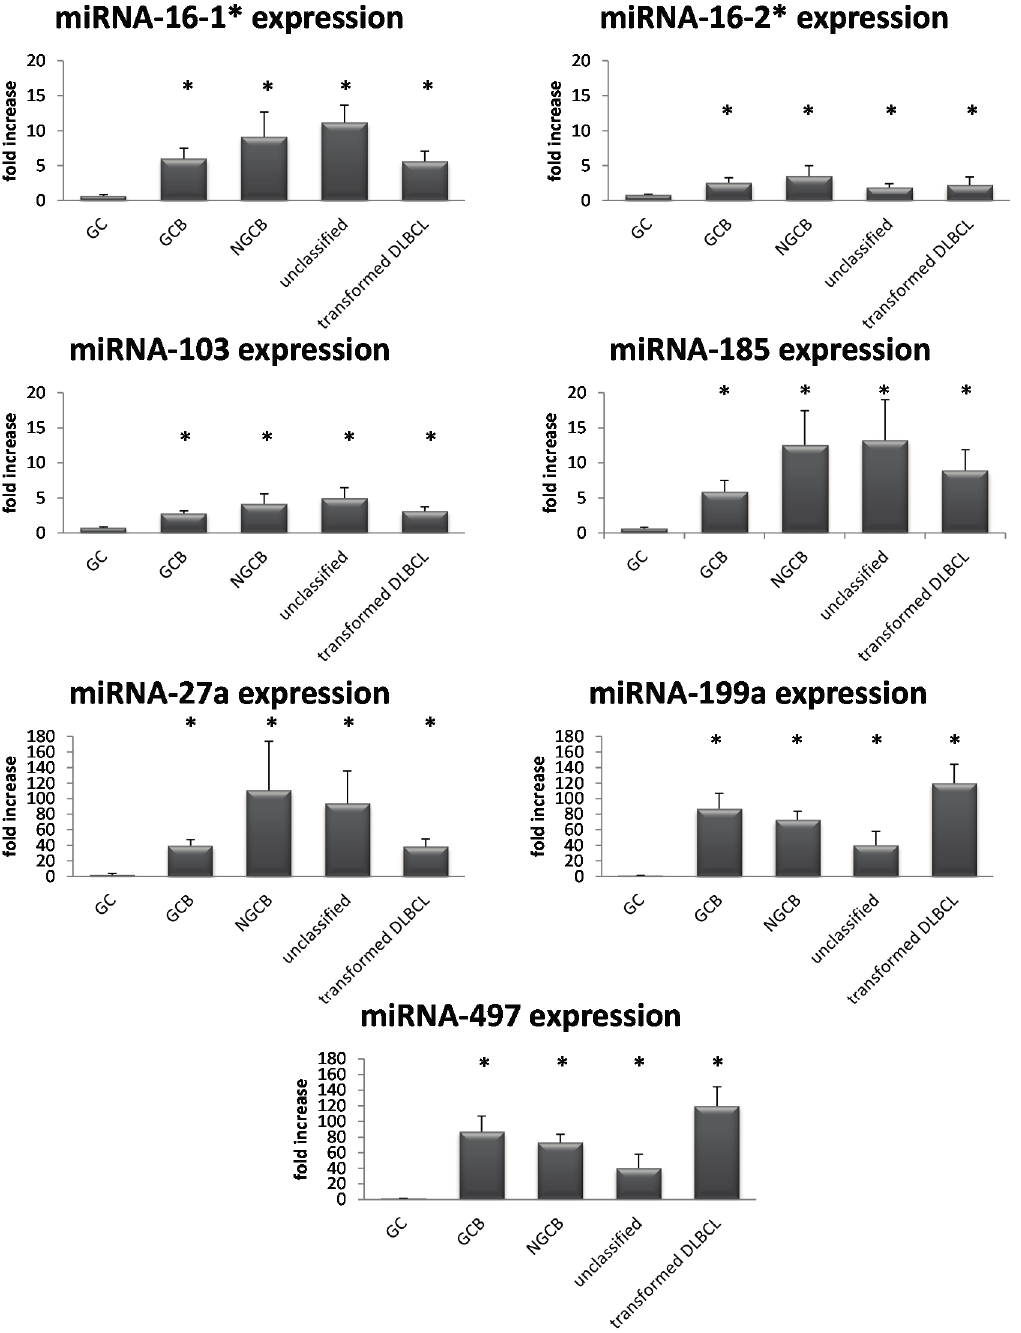
Figure 1. Expression levels of 7 miRNAs (miR-16_1*, miR-16_2*, miR-103, miR-185, miR-27a, miR-199a, and miR-497) according to their subtype. Each bar represents the mean fold increase of miRNA expression ± standard deviation. Statistically significant up-regulation of miRNAs in B-Non Hodgkin Lymphoma (B-NHL) compared to germinal center (GC) cells of at least 6-fold. The comparison of the expression levels was performed by using the Mann–Whitney U test. * indicates reduced expression compared with GC cells ( p <